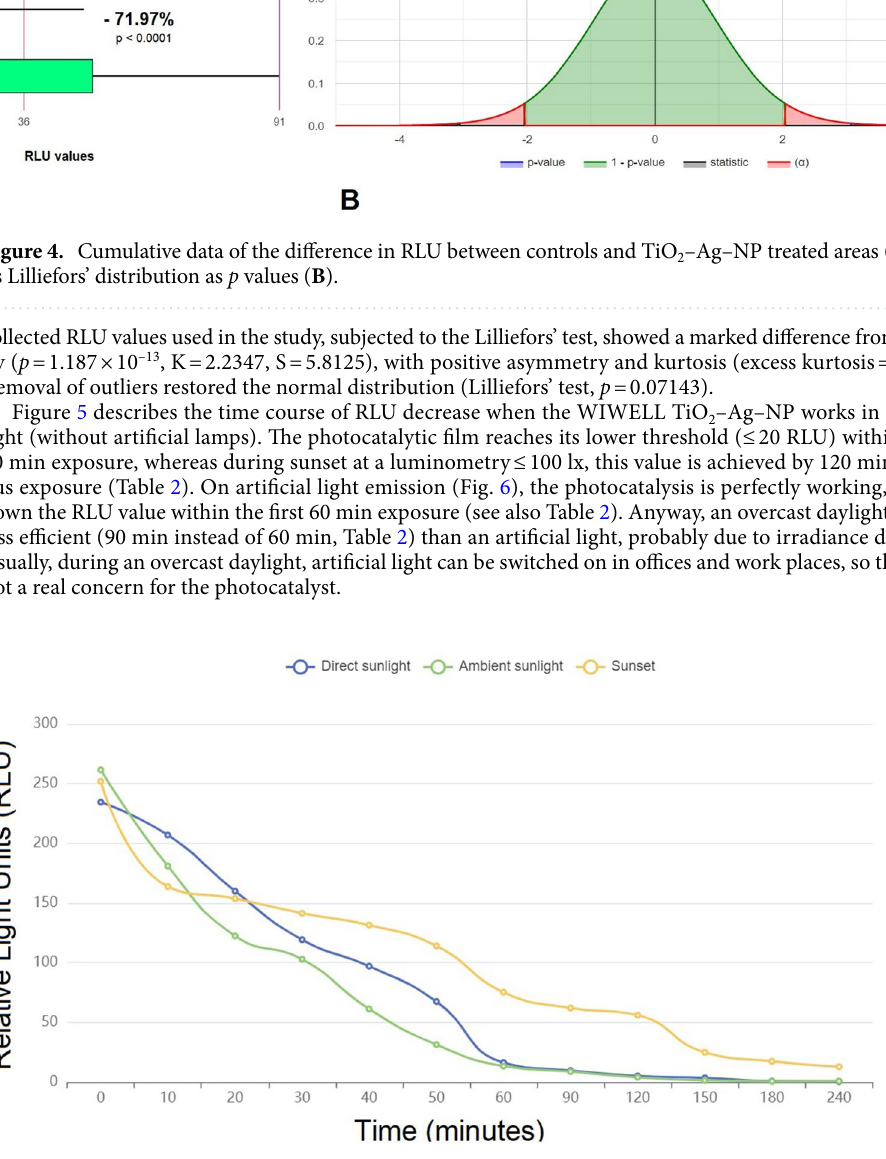
Figure 5. Time course of the WIWELL TiO 2 –Ag–NP photocatalytic film performance, evaluated in RLU, upon different daylight exposures: blue line (direct sunlight 60,000 lx); green line (ambient daylight 15,000 lx); orange line (sunset 100 lx). Plotting with Smart Statistics v.11 software.